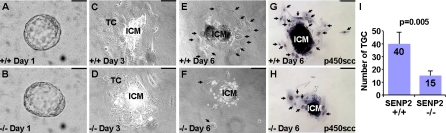
In Vitro Differentiation of SENP2-Null Blastocysts into Trophoblast Cells Is Defective(A–H) Isolated SENP2+/+ (A) and SENP2–/– (B) blastocysts were cultured for trophoblast differentiation in vitro. Images were taken at culturing day 1 (A,B), day 3 (C,D) and day 6 (E–H). TS cells, outgrowing from the trophectoderm, differentiated into a single trophoblast cell (TC) layer, whereas the ICM formed aggregates and sat on top of the trophoblast cells (C,D).Arrows indicated TGCs present in the cultures (E,F). The cultures were then analyzed by immunostaining of a trophoblast specific marker p450scc (brown) and counterstaining of hematoxylin (blue) on day 6 (G,H).(I) The graph represents the average number of TGC present in the SENP2+/+ and SENP2–/– cultures (p = 0.005, n = 6).Scale bars, 200 μm (E–H); 100 μm (C,D); 50 μm (A,B).